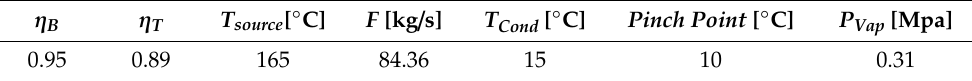
Table 3. System data used for model validation.